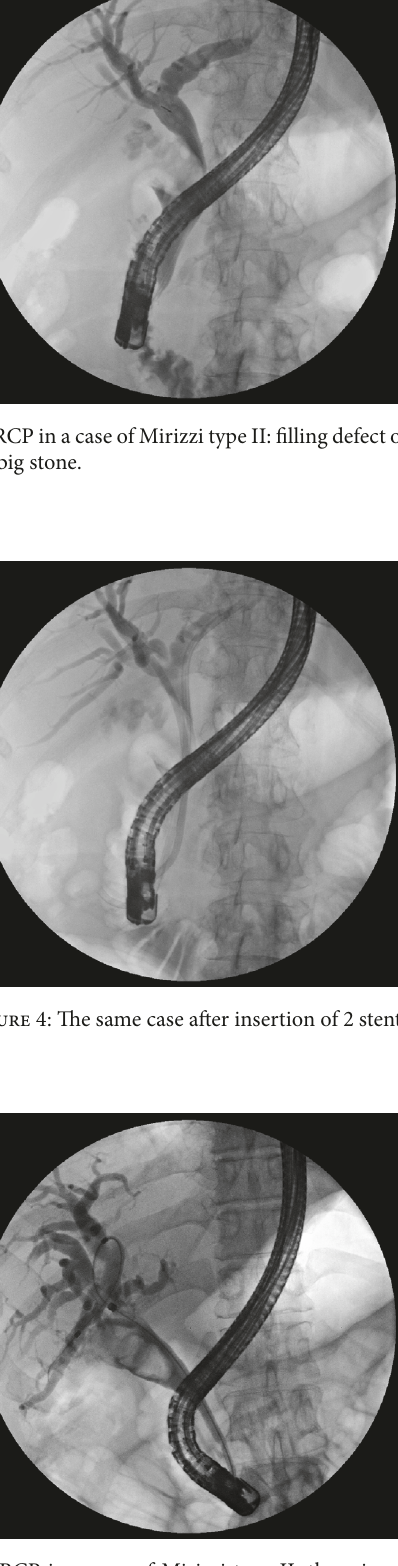
Figure 5: ERCP in a case of Mirizzi type II: there is a “common cavity” involving the gallbladder and the